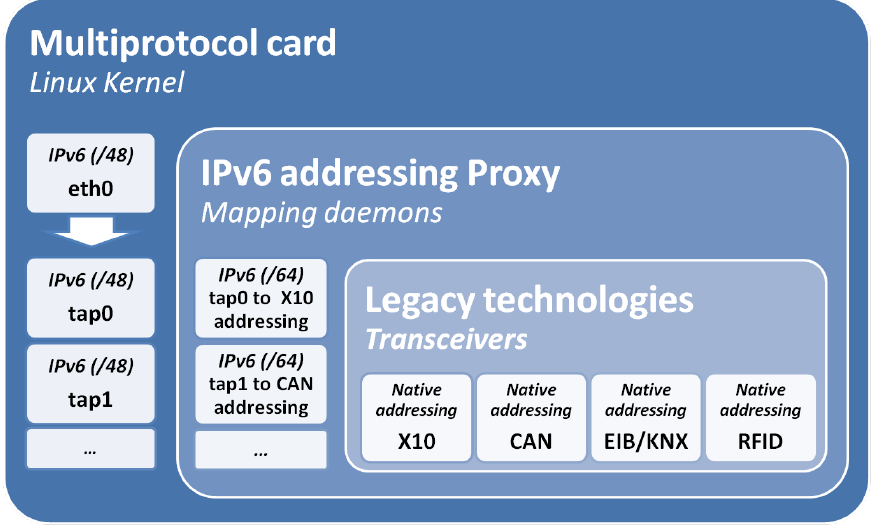
Figure 2. IPv6 addressing proxy functionality and mapping